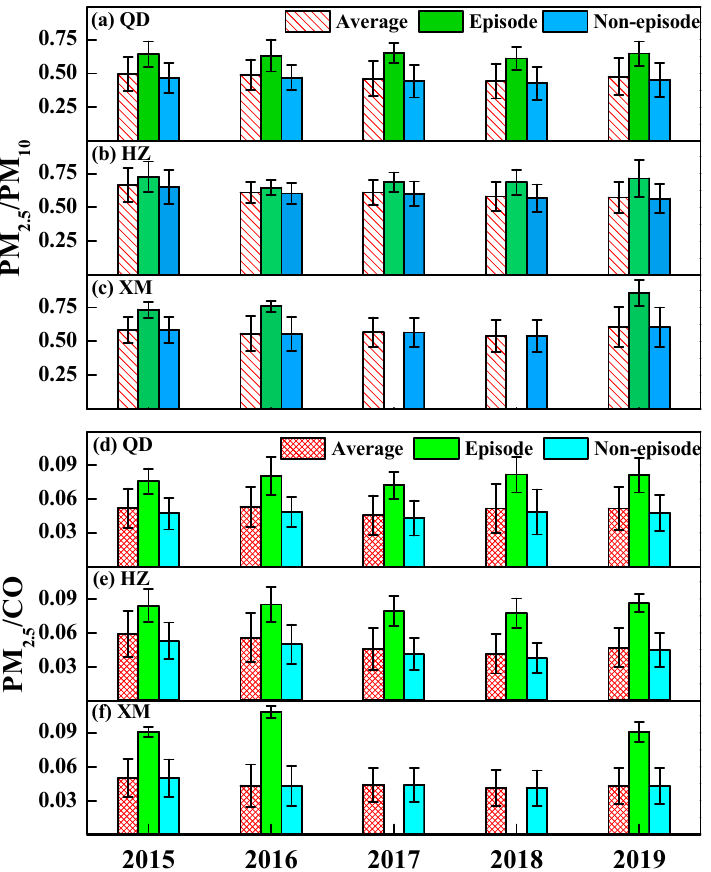
Figure 3. Inter-annual variations of PM 2.5 /PM 10 ( a – c ) and PM 2.5 /CO ( d – f ) in Qingdao (QD), Hangzhou (HZ) and Xiamen (XM) for all (episode and non-episode) periods during 2015–2019. The error bar represents standard deviation.